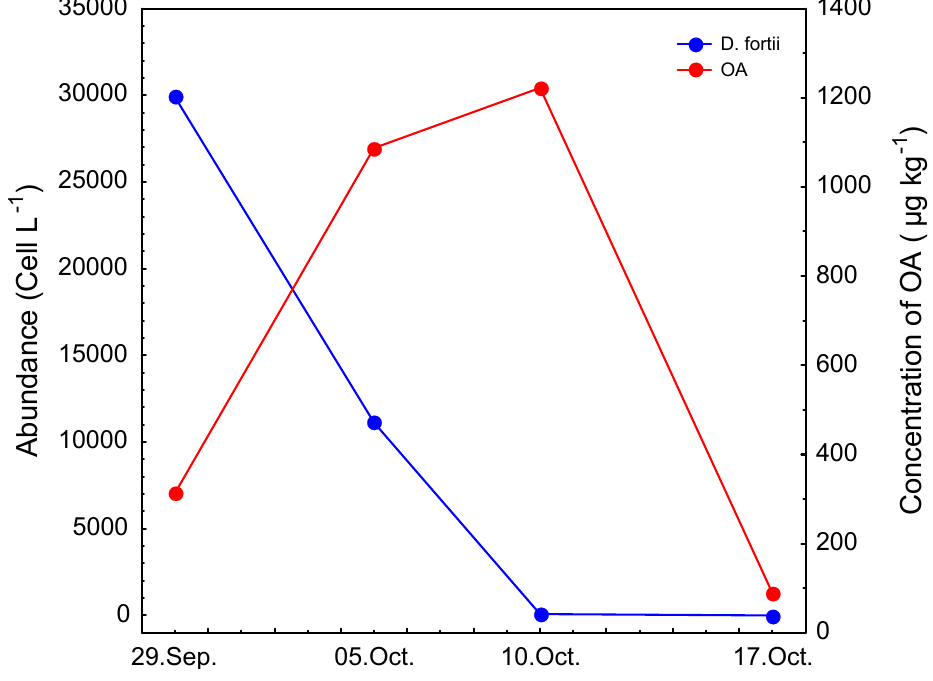
Figure 2. Abundances of D. fortii in water samples and concentrations of okadaic acid (OA) in shellfish samples obtained from Lim